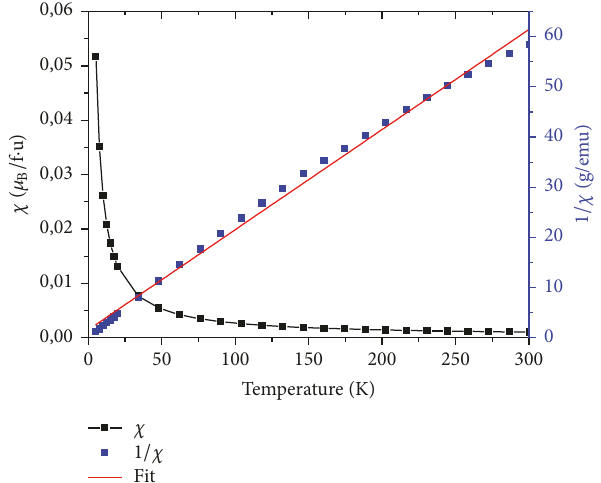
Table 5: Values of C, 𝜇 the